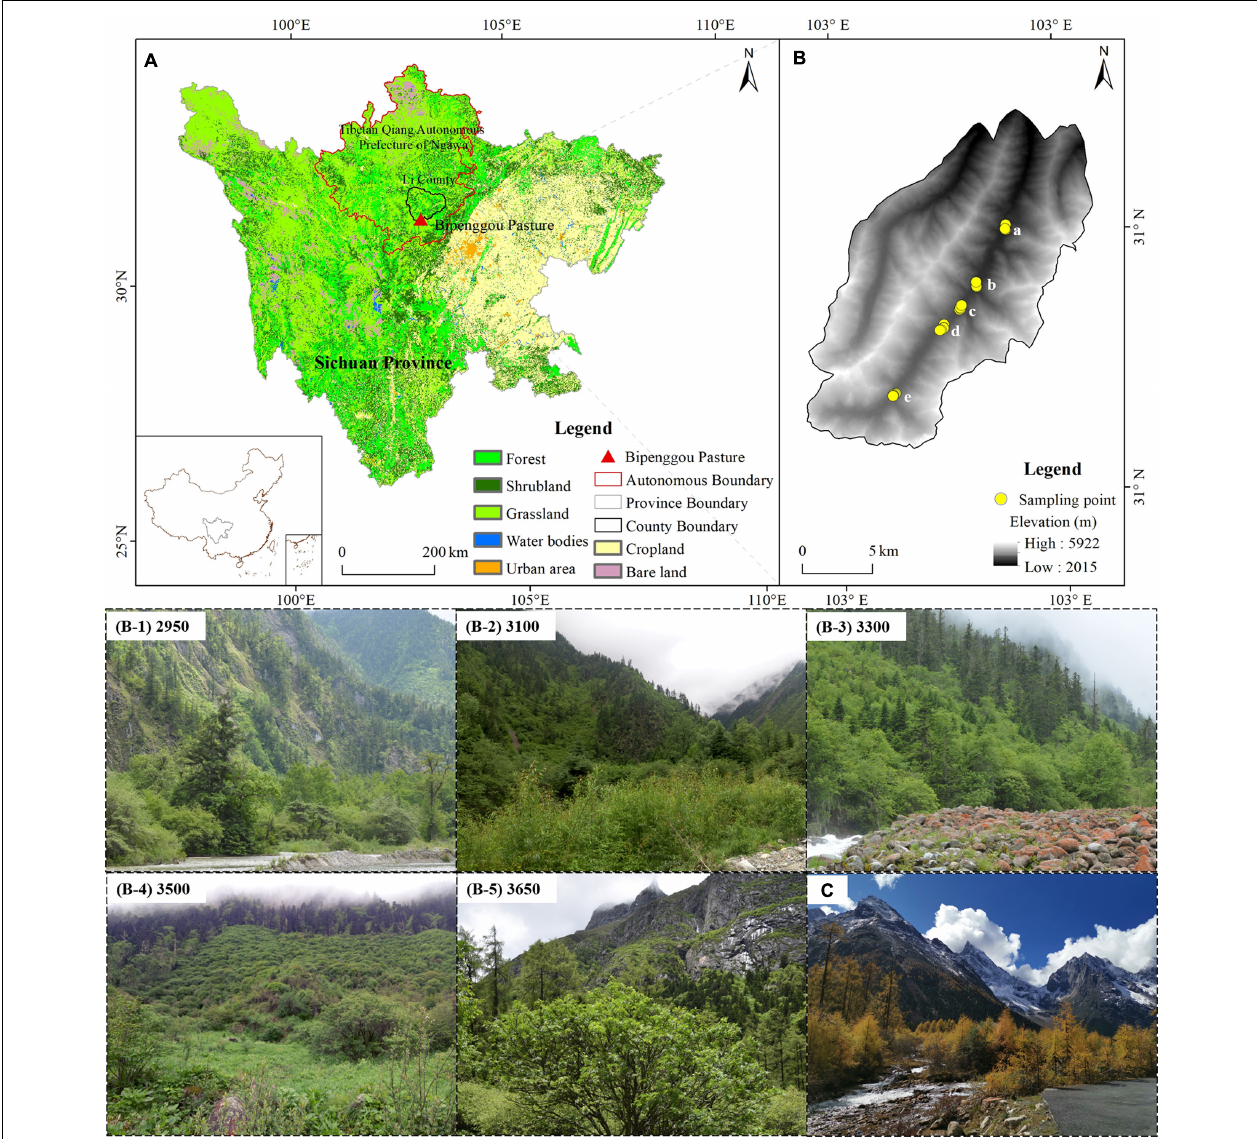
FIGURE 1 | Location of the study site and sampling plots as well as the overview of Bipenggou valley and the biotope of each plot along the valley: (A) location of Bipenggou valley, (B) location and biotope of sampling plots sited at 2,950–3,650 m, and (C) overview of the study